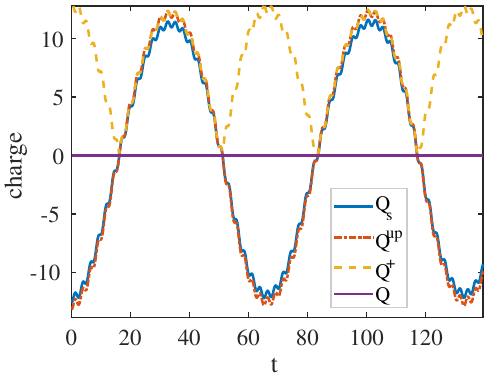
Figure 7 . Evolution of various charges. See figure 2 and the text below for the definitions of the quantities Q , Q up , Q + and Q s